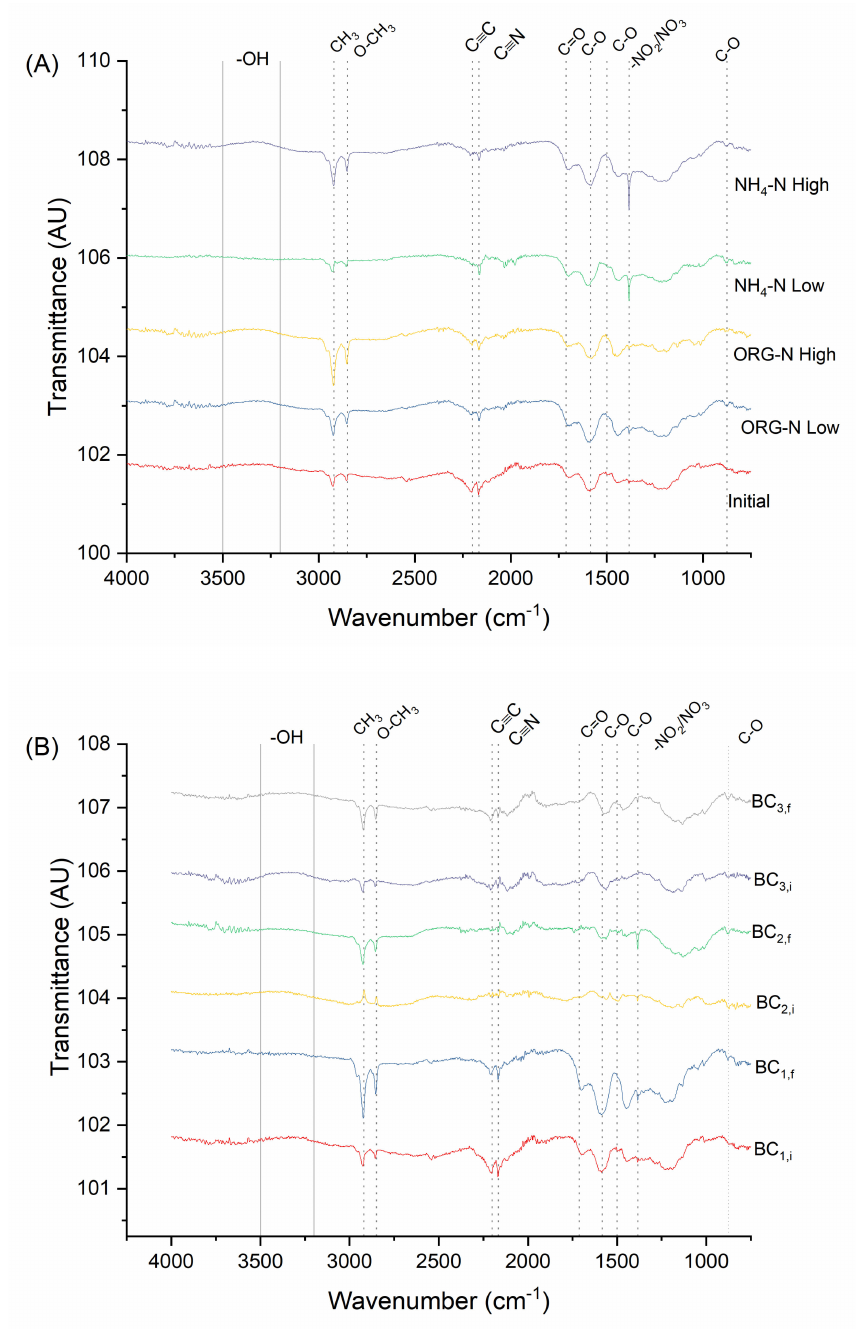
Figure 6. Fourier-transform infrared spectroscopy (FTIR) spectra of ( A ) BC 1 initial and final for treatments 1 through 4, and ( B ) BC 1, BC 2 , and BC 3 initial and final for treatment group